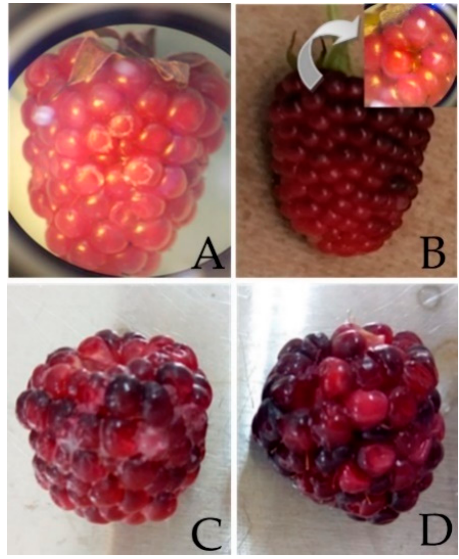
Figure 2. Blackberries appearance. ( A , B ) Coated and uncoated fruits on day 1. ( C , D ) Coated and uncoated fruits on day 19.